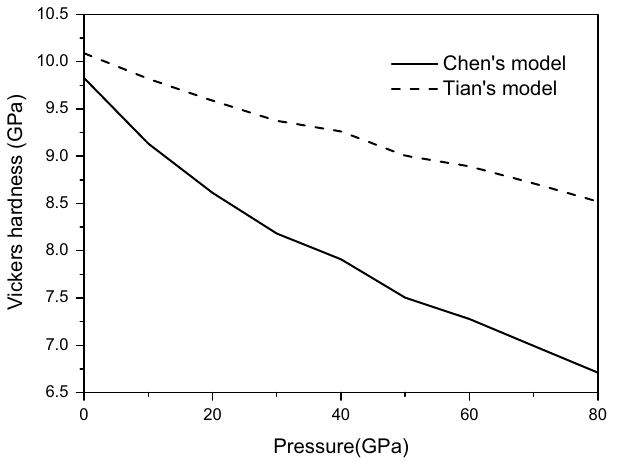
Figure 8. Vickers hardness of magnesite from 0 to 80 GPa.